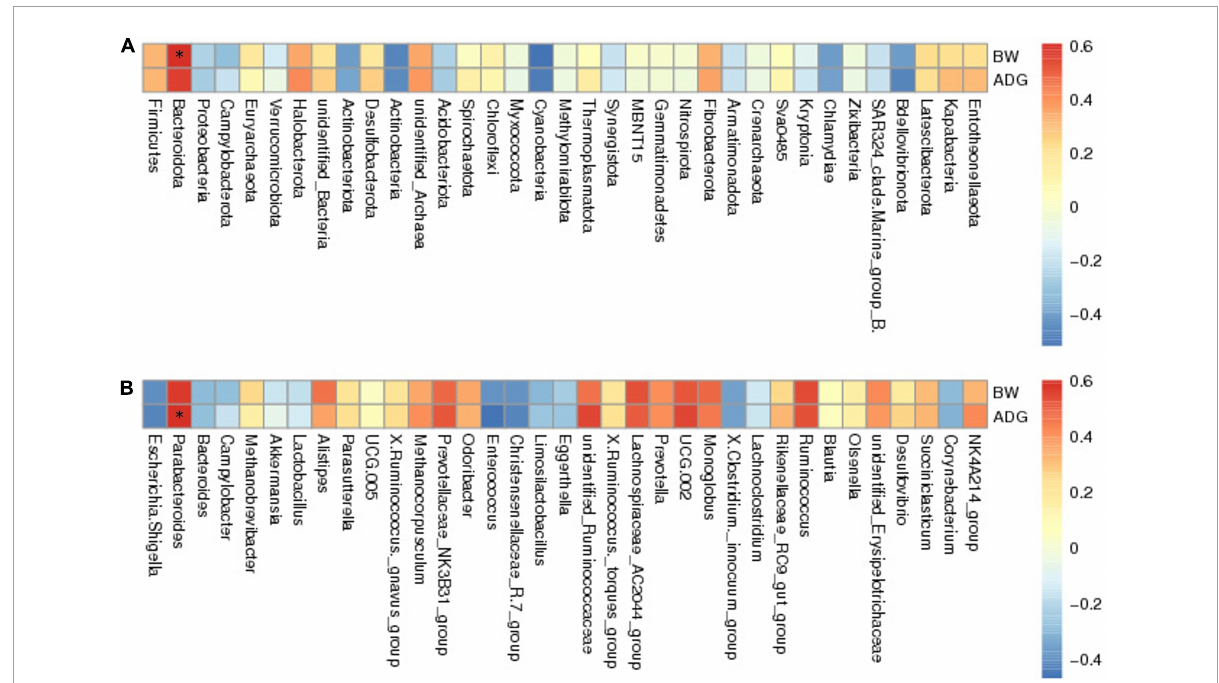
FIGURE5 The results of Spearman’s analysis show BW (body weight) and ADG (average daily gain) in the longitudinal direction, and each bacterial information in the transverse direction. (A) at phylum level. (B) at genus level. The value corresponding to the intermediate heatmap is the spearman correlation coefficient r, which is between − 1 and 1, r < 0 is negative correlation, r > 0 is positive correlation, and marked * indicates significance test p <